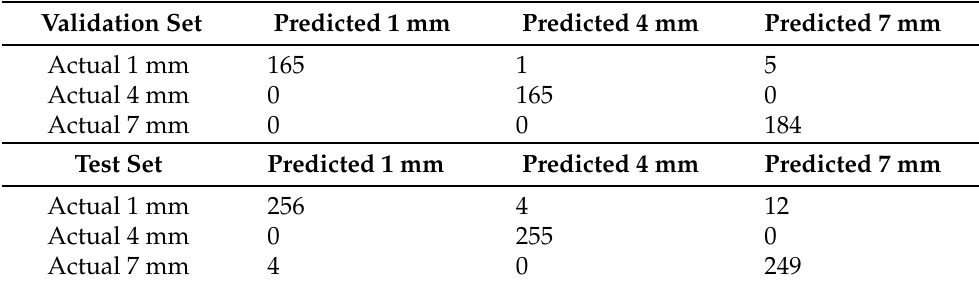
Table 5. Confusion matrix for DID-CNN.